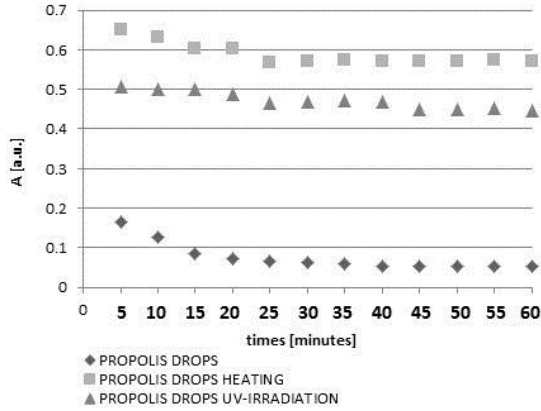
Figure 4. The effect of both heating at 50 °C and UV-irradiation on changes of amplitudes (A) of EPR lines of DPPH in contact with propolis drops with increasing interaction time (t). Times of both heating and UV-irradiation were 30 min.